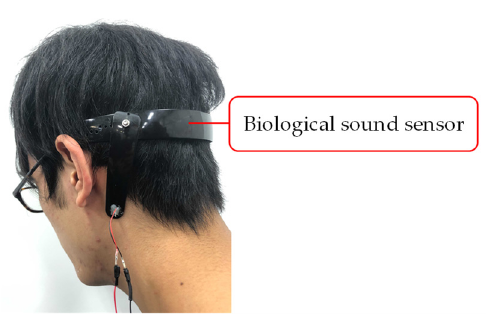
Figure 4. Photograph of a subject wearing the biological sound sensor.